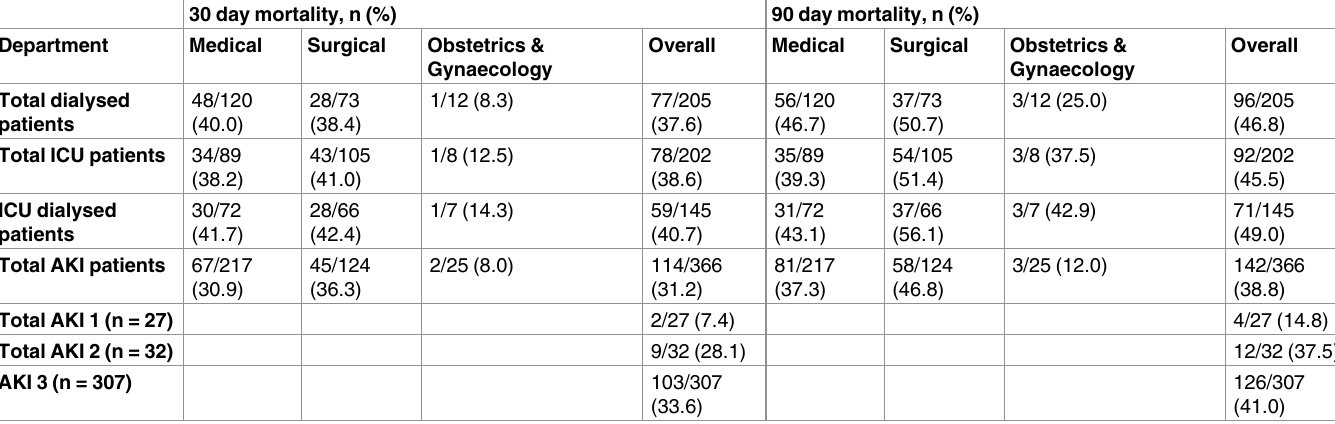
Table 3. 30 and 90 day mortality and associated patient characteristics.